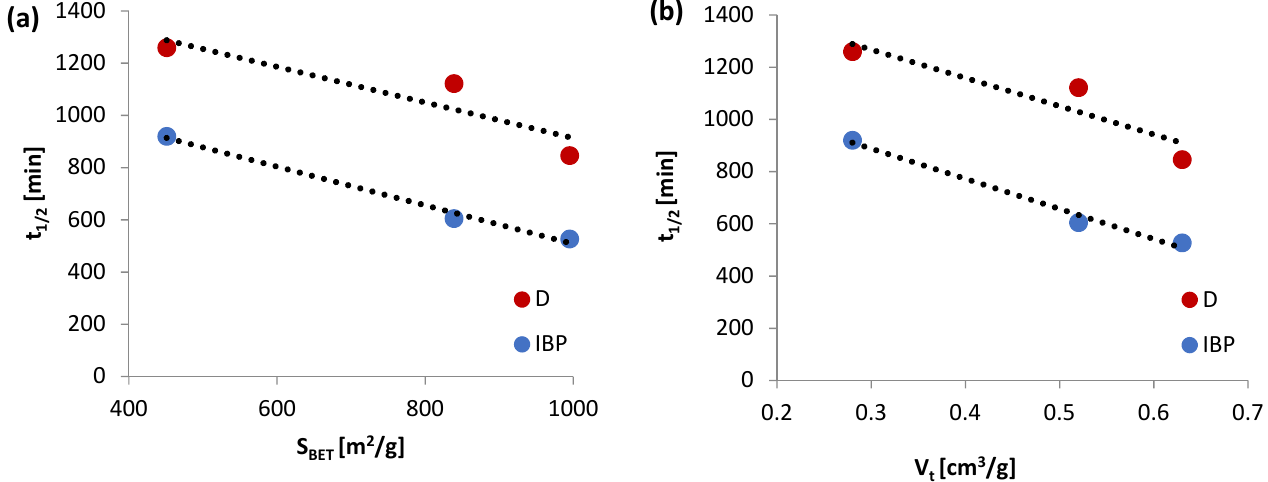
Figure 7. The dependence of half-times on S BET ( a ) and V t ( b ) for ibuprofen and diclofenac adsorbed on ALG_C2, ALG_C4, and ALG_C8 materials.